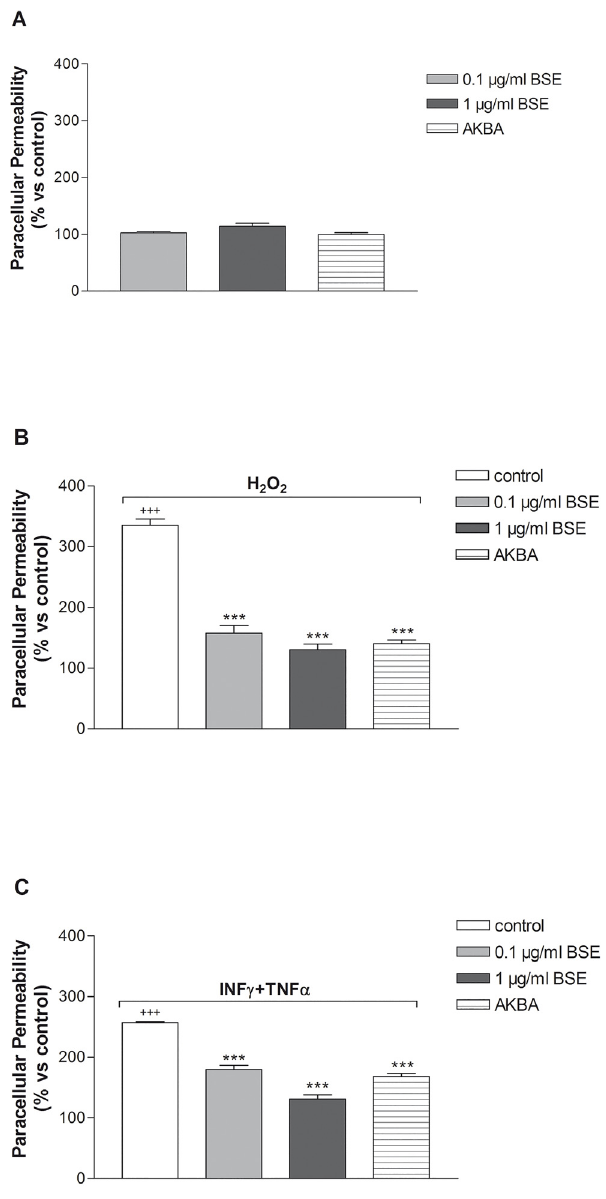
Fig 3. Effect of BSE and AKBA on Caco-2 cell monolayers paracellular permeability, measured by sodium fluorescein assay. A) basal condition. B) BSE and AKBA + H 2 O 2 ( +++ p < 0.001 H 2 O 2 vs control ** p < 0.01 BSE and AKBA vs H γ +TNF- α . *** p < 0.001 BSE and AKBA vs H 2 O 2 2 O 2 ). C) BSE and AKBA + INF- ( +++ p < 0.001 INF γ +TNF α vs control + p < 0.05 INF- γ +TNF- α vs control *** p < 0.001 BSE and AKBA vs INF- γ +TNF- α ). Data are shown as mean ± SEM percentage of basal fluorescent intensity (FI) of n = 3